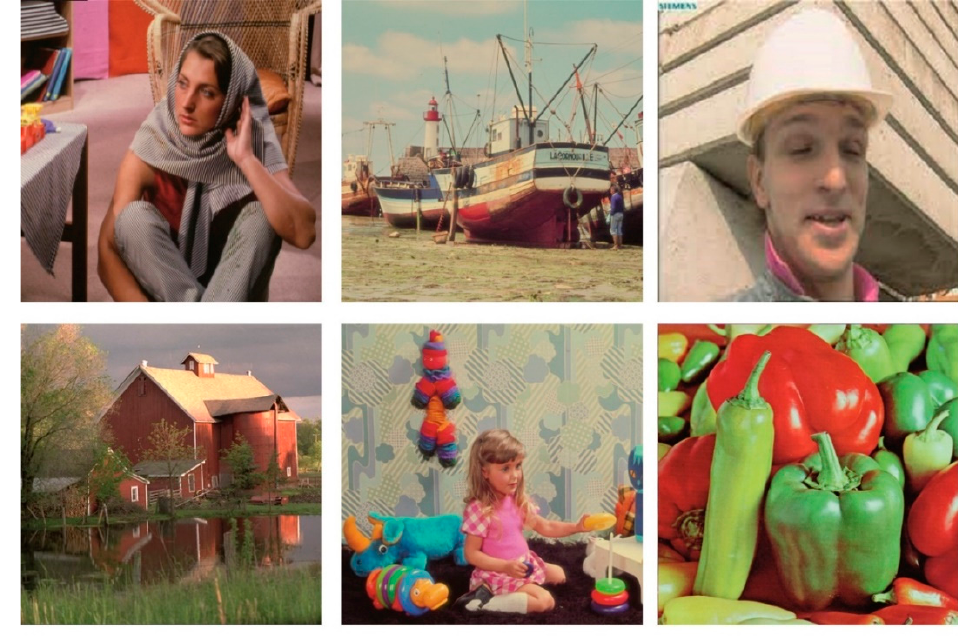
Figure 4. Sample set of Secret Images.